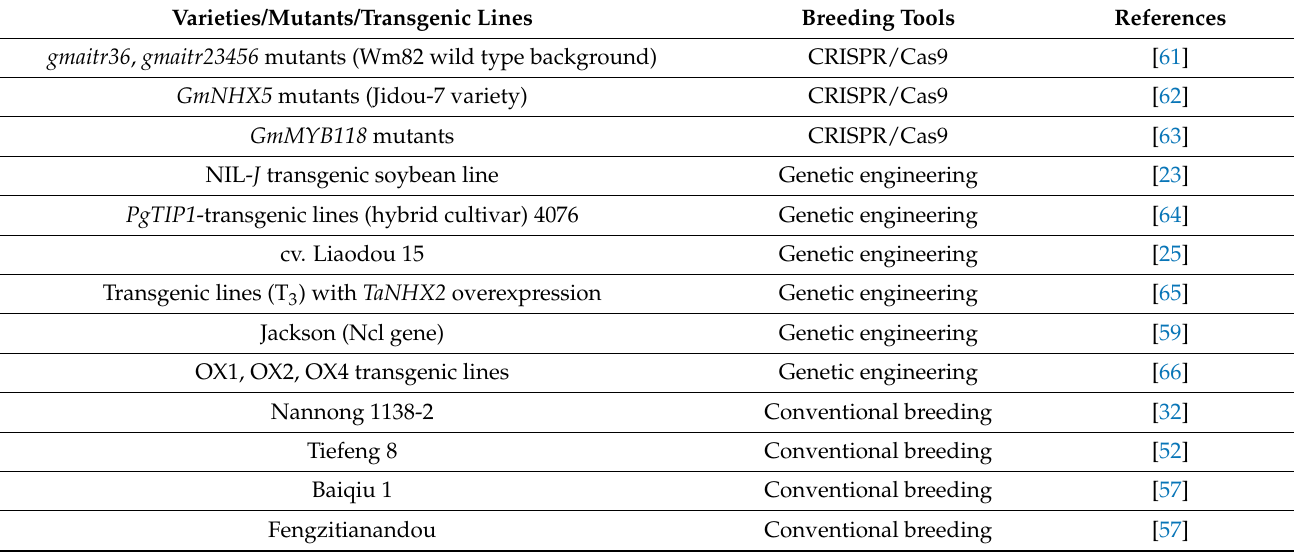
Table 2. Developing salt-tolerant cultivars/mutants in soybean using conventional and molecular breeding